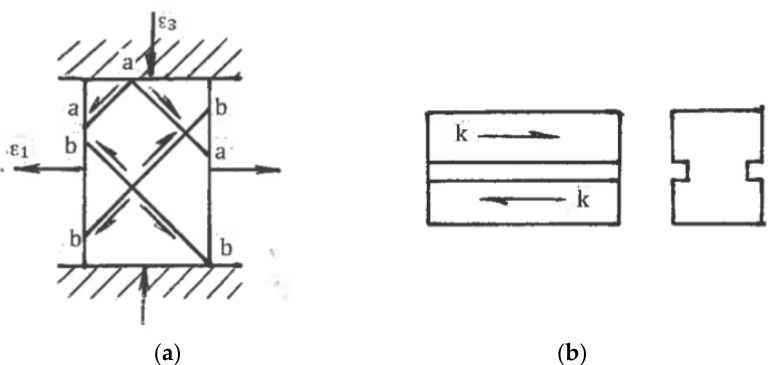
Figure 8. Transition from pure shear to simple shear after flow localization during frictionless upsetting ( a ) and simple shear of thin layer ( b ).